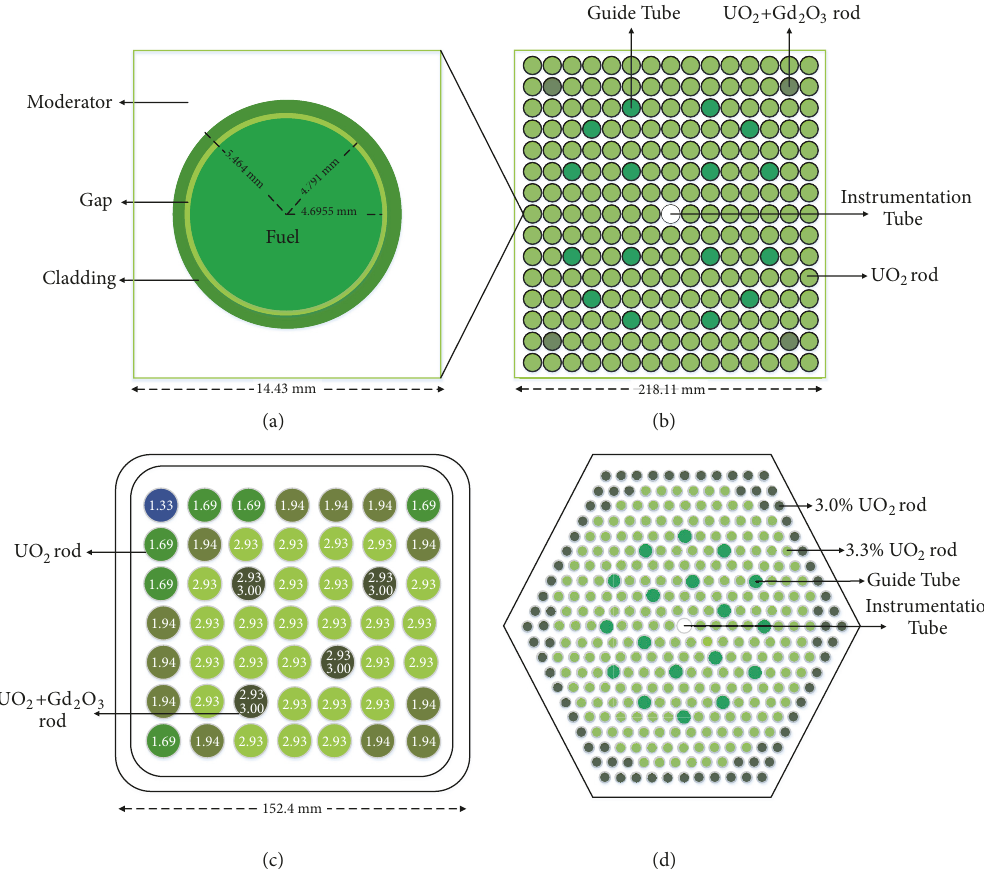
Figure 3: Sketch of the LWR test models used in this study: (a) PWR pin-cell, (b) PWR 15x15 lattice, (c) BWR pin-cell, (d) BWR 7x7 lattice, (e) VVER-1000 pin-cell, and (f) VVER-1000 lattice, based on the UAM benchmark [16]. Table 4: The correlation matrix between the group parameters of U-235 thermal fission as reported by